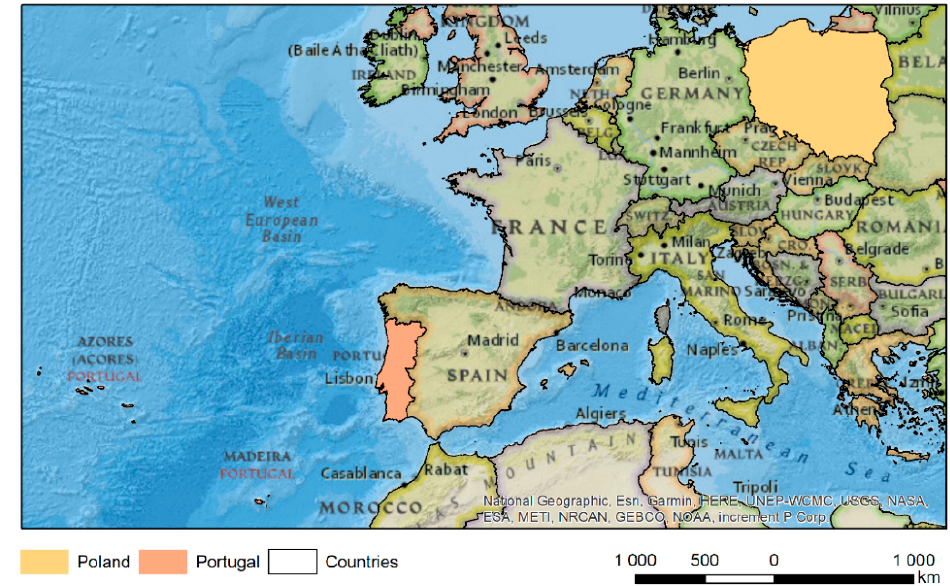
Figure 1. Location of Poland and Portugal.